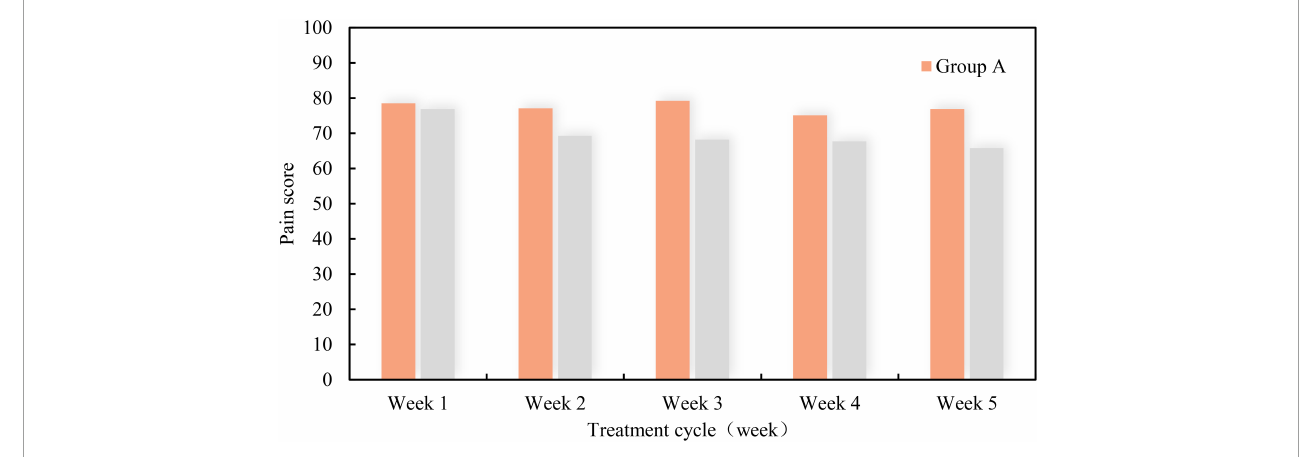
FIGURE6 Pain score of breast cancer patients within 5 weeks under two treatment methods.